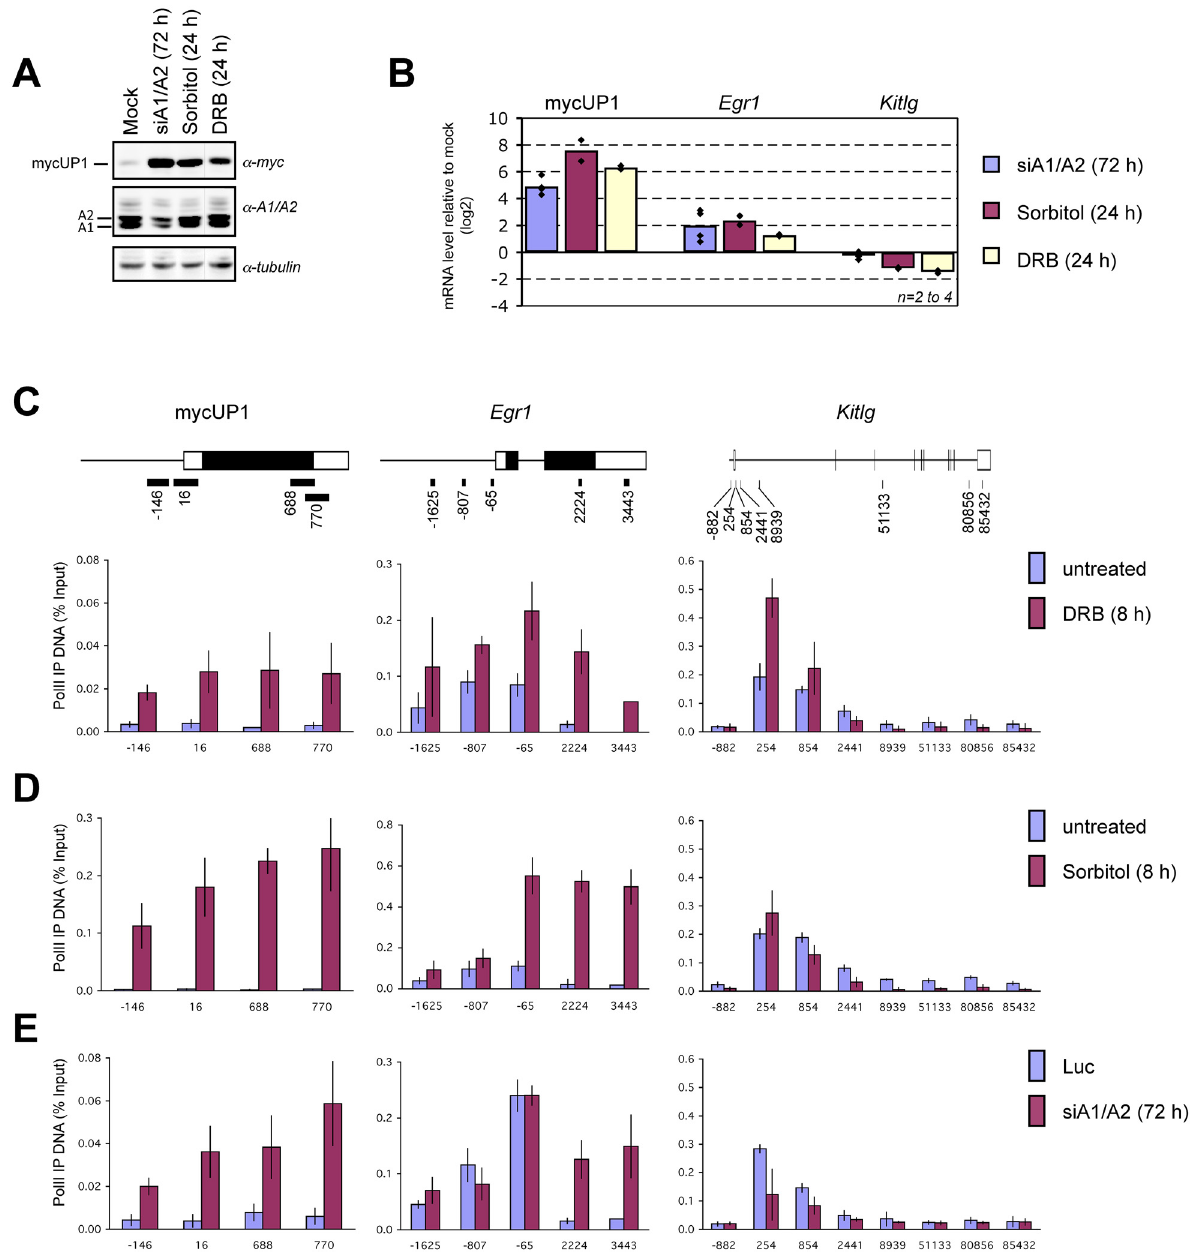
Fig 3. Depleting nuclear hnRNP A1/A2 mimics the effect of the transcription elongation inhibitor DRB. A , The P-TEFb kinase CDK9 was inactivated by treating cells with DRB (100 μ M) for 24 hours. The impact on mycUP1 protein expression was compared to the impact of a 1 hour treatment with sorbitol (cells harvested 24 hours later), treatment with siA1/A2 for 72 hours or untreated (mock). B , Quantitative RT-PCR was used to measure the impact of siA1/ A2, sorbitol or DRB on the steady state levels of mycUP1 transcripts from the reporter, and endogenous Egr1 and Kitlg transcripts. Levels are expressed relative to the mock treatment. C , Occupancy profiling of RNA polymerase II on the mycUP1, Egr1 , Kitlg and genes. ChIP assays were performed with extracts of H55-34 cells using the pol II antibody H-224. A linear map of each gene locus is provided. Exons are represented by boxes and coding sequences are in black. The location of amplicons used in qPCR is shown below and numbers indicate the relative position of the center of the amplicon relative to the transcription start site. Pol II-ChIP performed on extract produced after DRB treatment (100 μ M) for 8 hours. D , Pol II-ChIP performed on extract prepared 8 hours following the application of sorbitol for 1 hour. E , Pol II/ChIP performed on extract from a 72 hours of RNAi treatment targeting hnRNP A1 and A2. For panels C – E, the DNA recovered after ChIP was quantitated by qPCR using the indicated amplicons. Values are expressed as percentage of input DNA. Error bars indicate standard deviations and are based on three independent